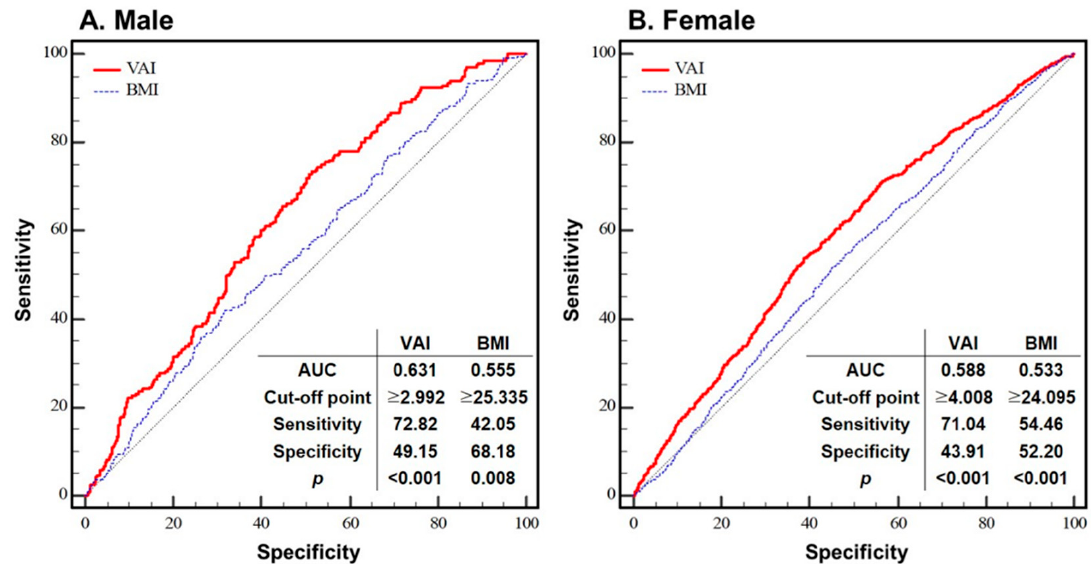
Figure 4. The ROC curves of the VAI and BMI plotted against MS CKD for each sex. Thin black line: reference; solid red line: area under the curve (AUC), indicating the accuracy of the VAI for the identification of MS CKD; thin dotted blue line: area under the curve (AUC), indicating the accuracy of the BMI for the identification of MS CKD; cut-off point: the value of VAI or BMI that predicts MS CKD; sensitivity: the probability of individuals who actually have MS CKD to be predicted to have MS CKD; specificity: the probability of individuals who do not have MS CKD to be predicted not to have MS CKD. Abbreviation: VAI = visceral adiposity index; BMI = body mass index; AUC = area under